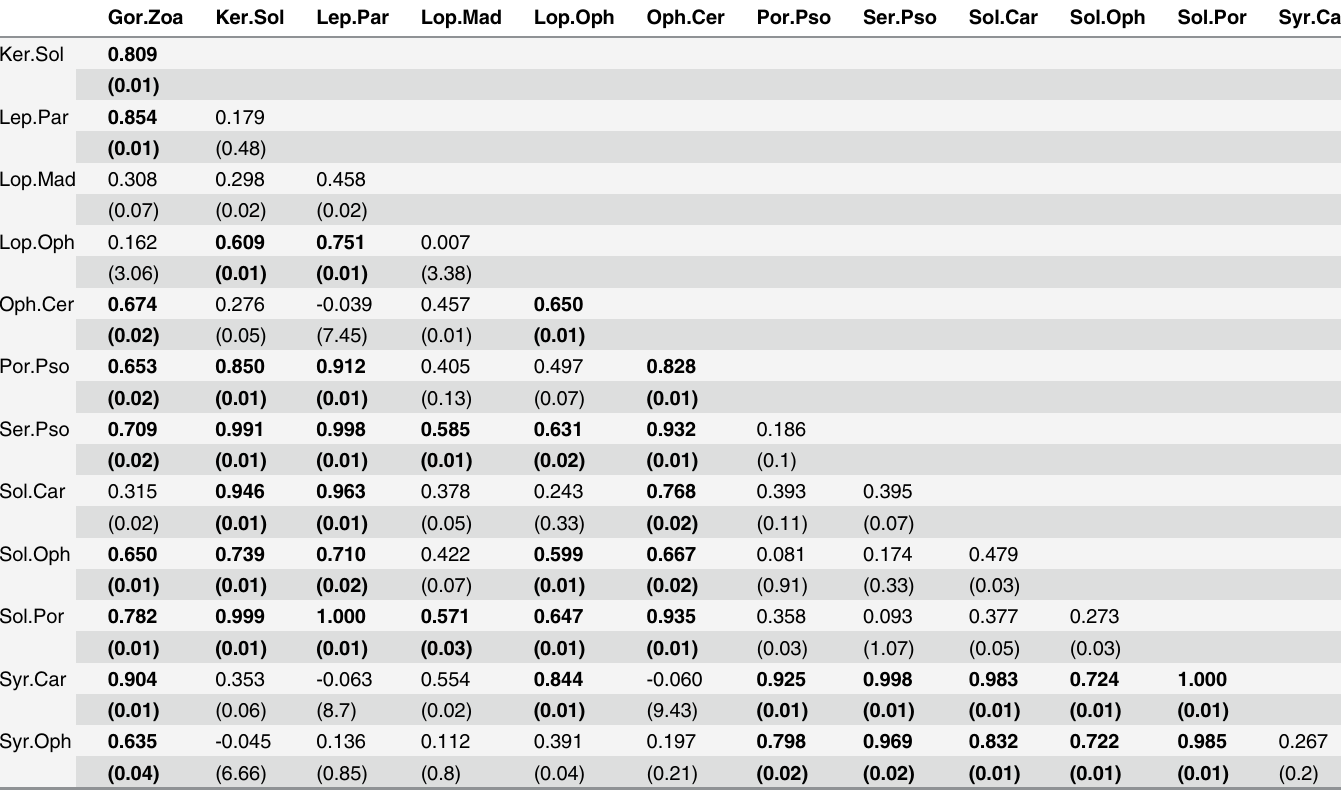
Table 4. ANOSIM pairwise test results for multivariate diversity test.